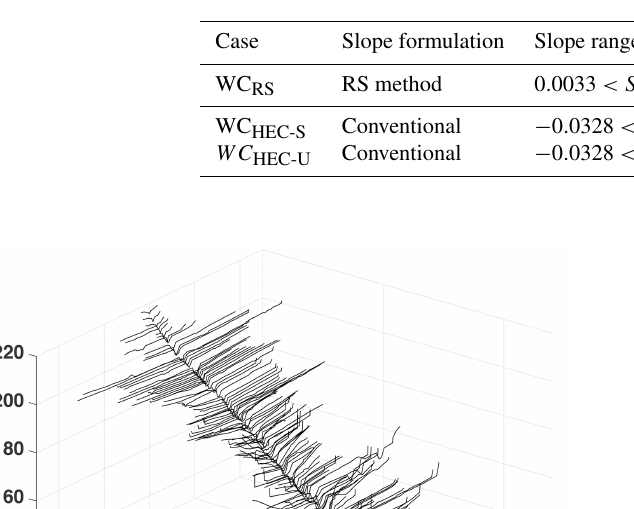
Figure 9. Main stem of Waller Creek and catchment in Austin (Texas, USA). Basemap © by Open Geospatial Consortium (OGC) Web Mapping Service (WMS). Table 3. Data for model setup of Waller Creek test cases.